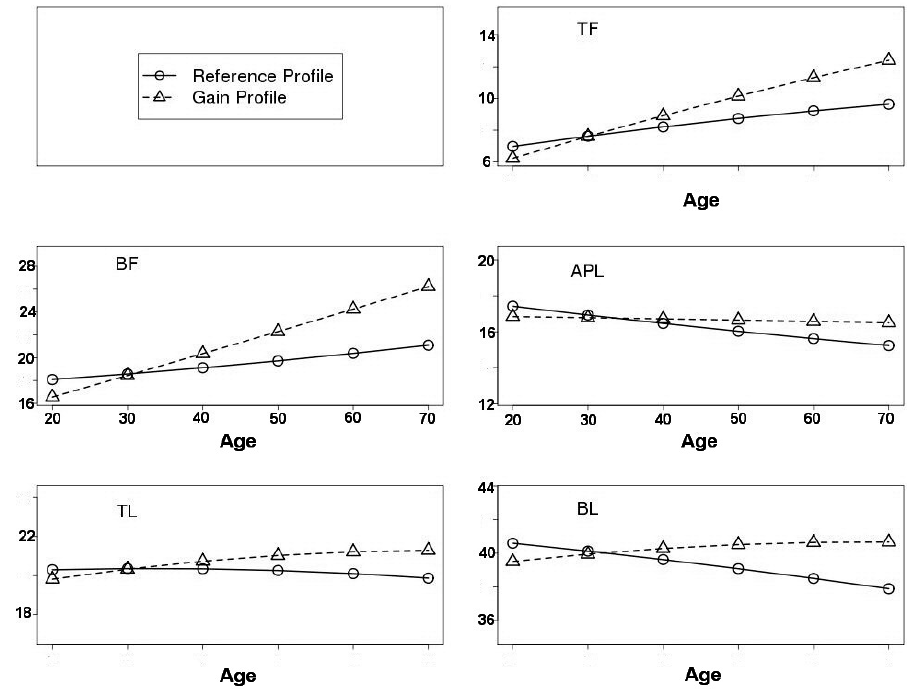
Figure 2. Age-related changes in segmental body composition for NHANES European-American normal women. Age is on the x -axis, and estimates of segmental body compositions from M 11 B , E ( A ) on the y -axis. Reference Profile is represented by (o) and Gain Profile by ( ∆ ).